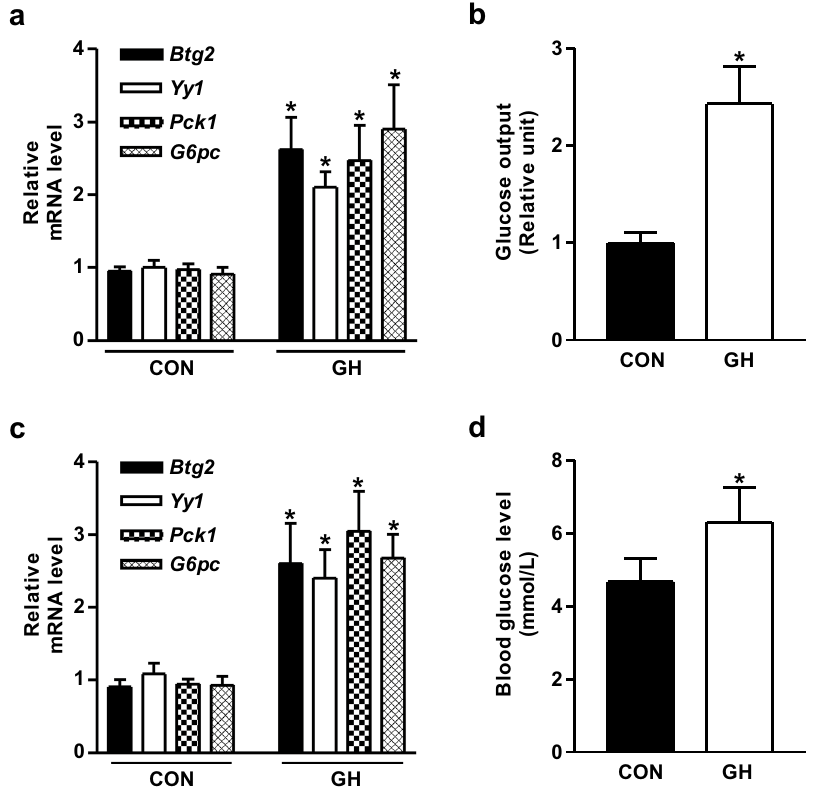
Figure 1. Growth hormone elevates hepatic gluconeogenesis in mouse primary hepatocytes and mouse liver. ( a ) Mouse primary hepatocytes (MPH) were treated with growth hormone (GH, 500 ng/ml) for 3 h. Gene expressions were analyzed by qPCR using the indicated primers. ( b ) Glucose output assay in MPH exposed to GH for 3 h. ( c ) Male C57BL/6 wild-type (WT) mice were injected intraperitoneally with GH (2 μg/g) for 7 days. ( d ) Blood glucose concentrations were measured from the indicated groups. n = 5 mice per group. * P < 0.05 vs. untreated control cells and